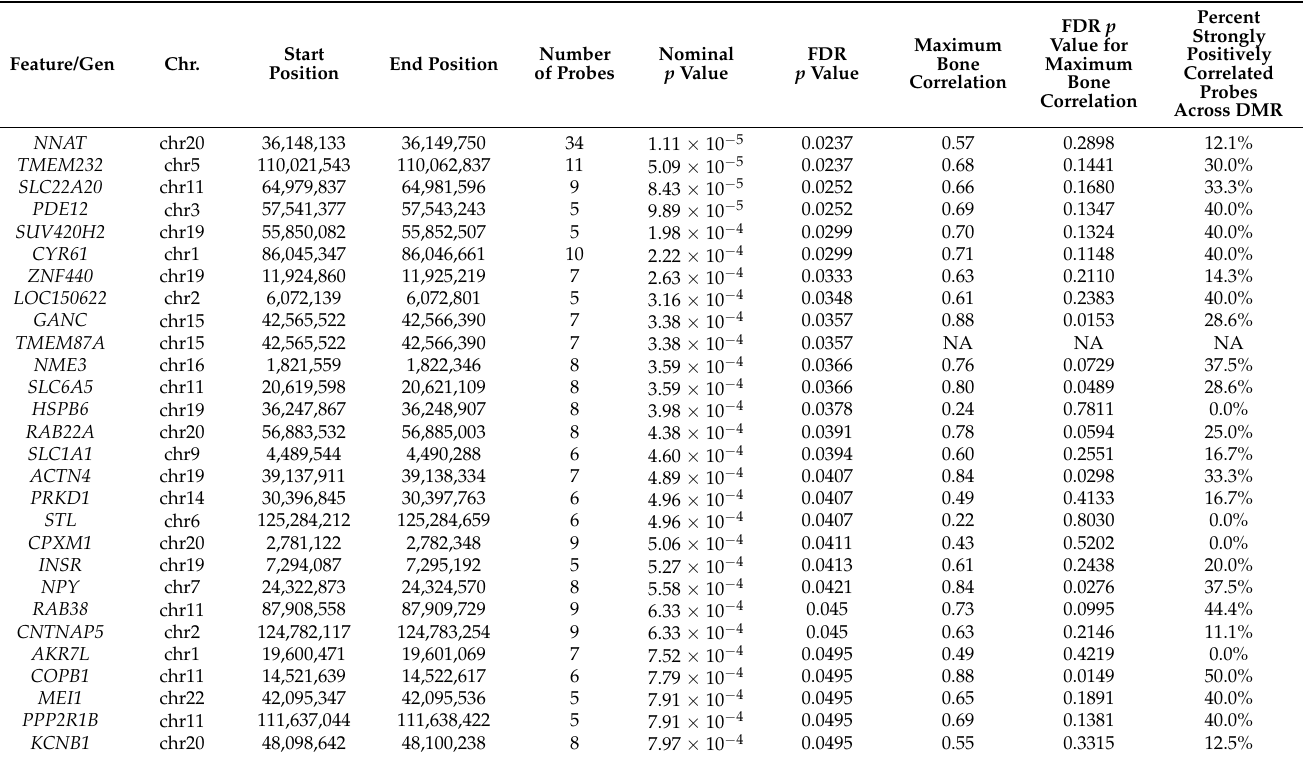
Table A4. Analysis of Curve Severity in Twin Pairs Identified 28 Differentially Methylated Regions where Slope Representing Association between Difference in Methylation and Difference in Curve Severity within each Twin Pair was Consistent Across all Probes in the